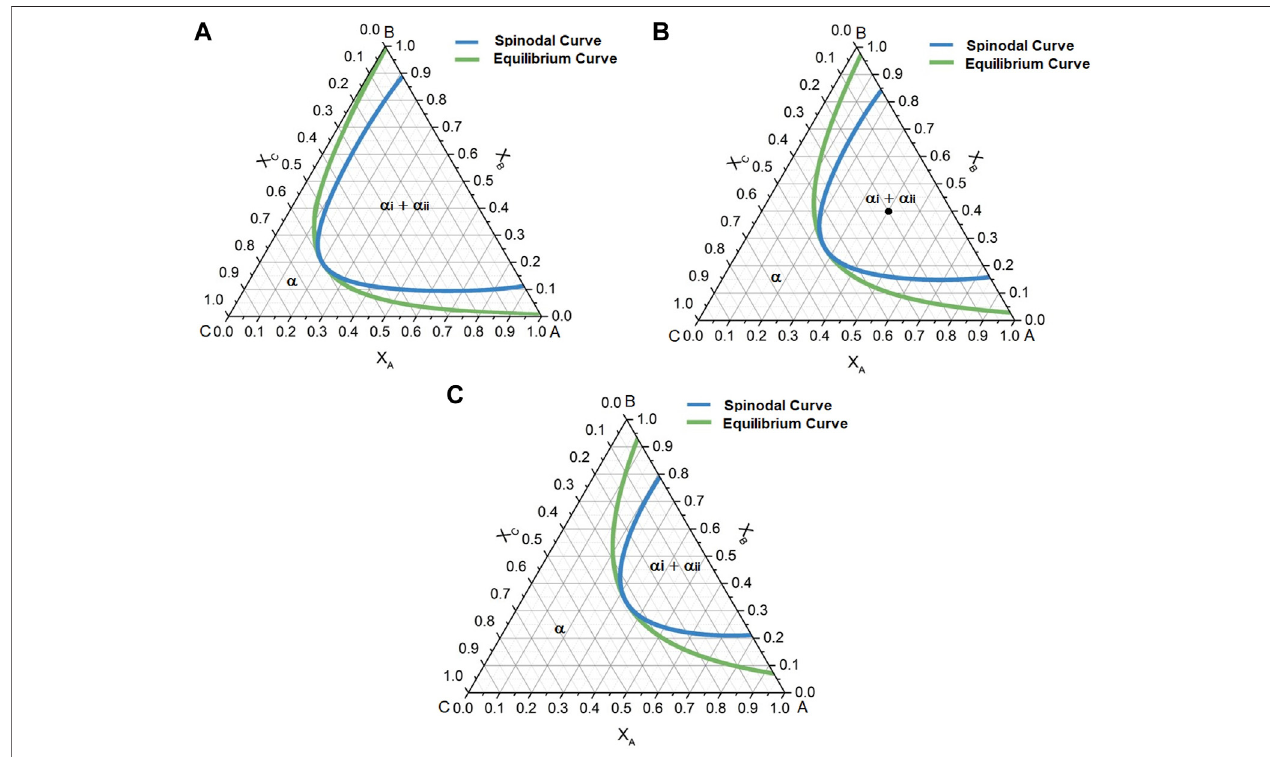
FIGURE 4 | Isothermal sections of the miscibility gap and spinodal curve for the A – B – C alloy system with Ω AB = 25,000 J/mol and Ω BC = Ω CA = 0 J/mol at (A) 600 K, (B) 800 K, and (C) 1000 K.